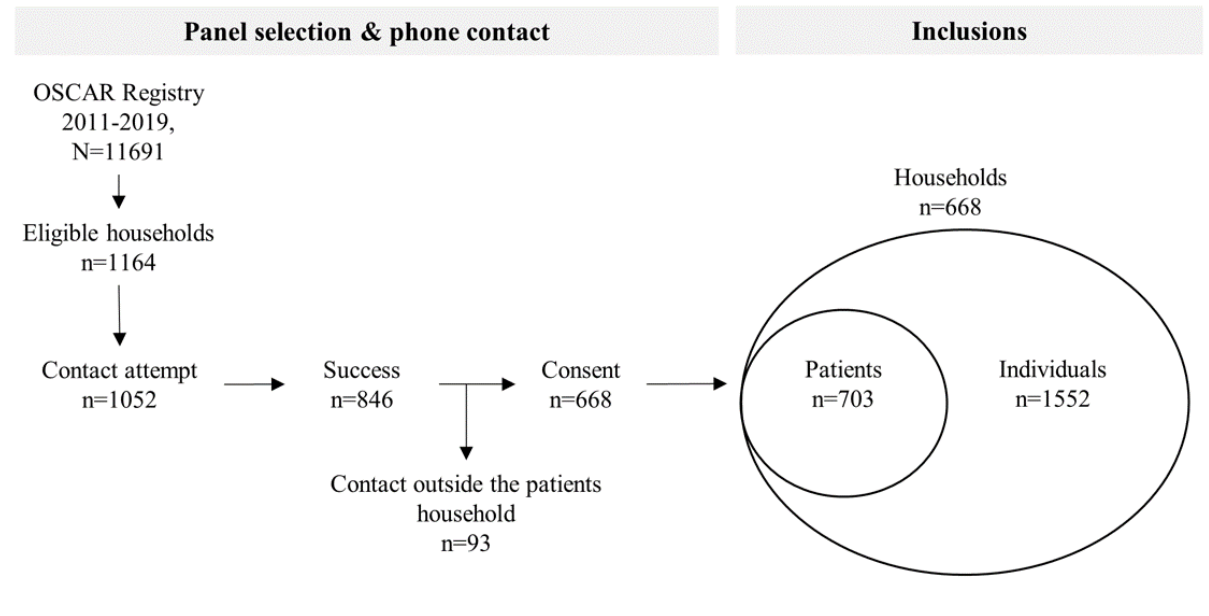
Figure 1. Flowchart of the panel sample selection and the final inclusions households and individuals with myocardial infarction history (patients) and without myocardial infarction history. OSCAR: Observatoire des Syndromes Coronariens Aigus du Réseau Regional Emergency Cardiovascular